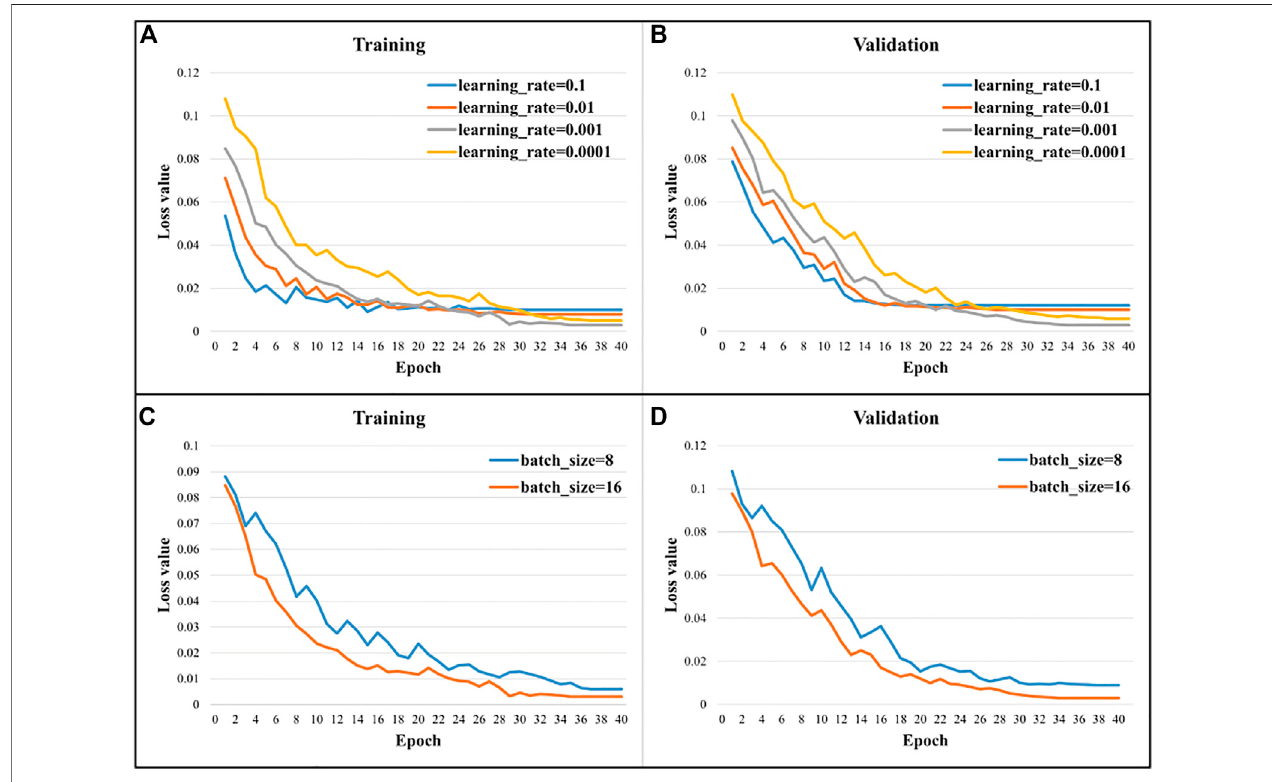
FIGURE 5 | Sensitivity analysis. (A,B) Loss value with different learning rates. (C,D) Loss value with different batch sizes.